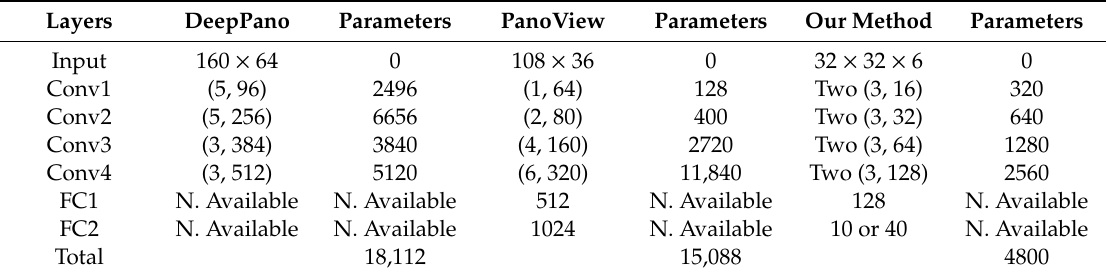
Table 3. The total number of parameters for all convolution layers in di ff erent